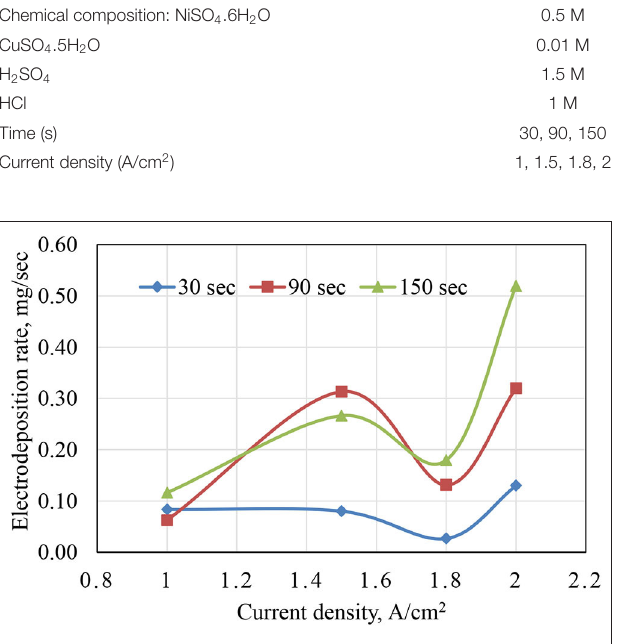
FIGURE 1 | Rate of electrodeposition of Ni–Cu as a function of current density and